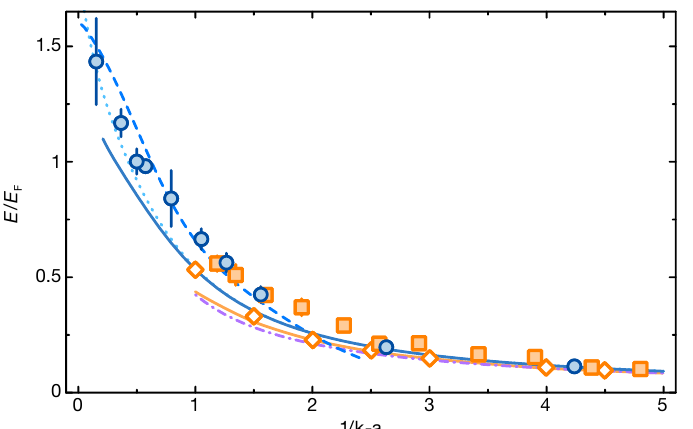
Figure 3. Energy of repulsive Fermi polarons (blue symbols and lines) and Bose polarons (orange symbols and lines) in the equal-mass case. RF spectroscopy experimental data are taken from Ref. [23] (filled blue circles) and Ref. [38] (filled orange squares). We also display theoretical results obtained by a non self-consistent T -matrix approach [77] (solid blue line), functional renormalization group [83] (dashed blue line) and a variational wavefunction [78] (dotted light blue line) for the repulsive Fermi polaron, and by the truncated basis method (TBM) [35] (solid orange line) and fixed-node diffusion QMC [38] (empty orange diamonds) for the repulsive Bose polaron. The mean-field prediction E = 4 π na / m ≡ E F 4 k F a (purple dot-dashed line) coincides for the Bose and Fermi 3 π